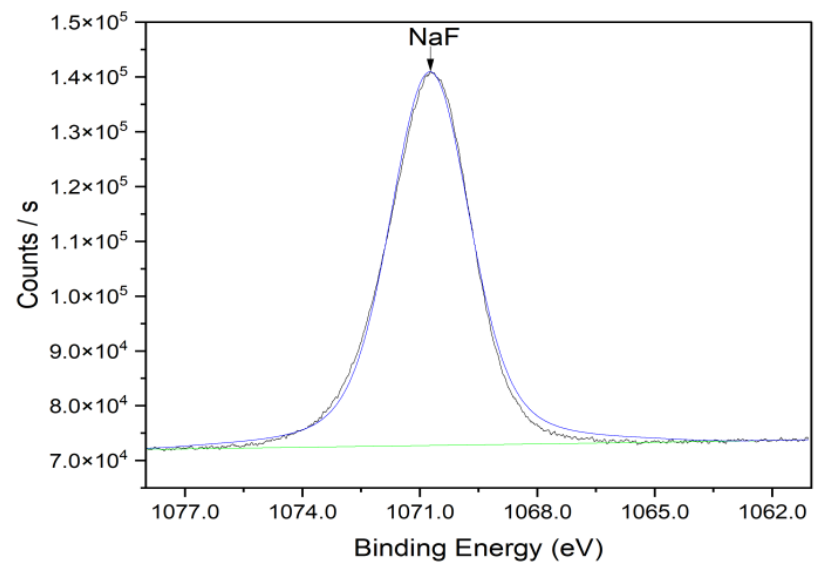
Figure 7. High-resolution scan of Na1s of the modified Nafion material centered at 1070.74 eV. The black curve is the scan data; the blue curve is the fitted data, and the green curve is the baseline. Table 2 provides film thickness values and the surface roughness (Sa) for 3 screen- printed Nafion membranes characterized by LSCM. The fabricated films showed good repeatability in thickness. Sa is the average surface area roughness of the Nafion membranes. The overall Sa accounts for approximately 20% of the film thickness over the area of the deposited films. The level of roughness is likely due to the amorphous morphology of the cured Nafion membranes. Table 2. LSCM film thickness and roughness measurements of screen-printed Nafion